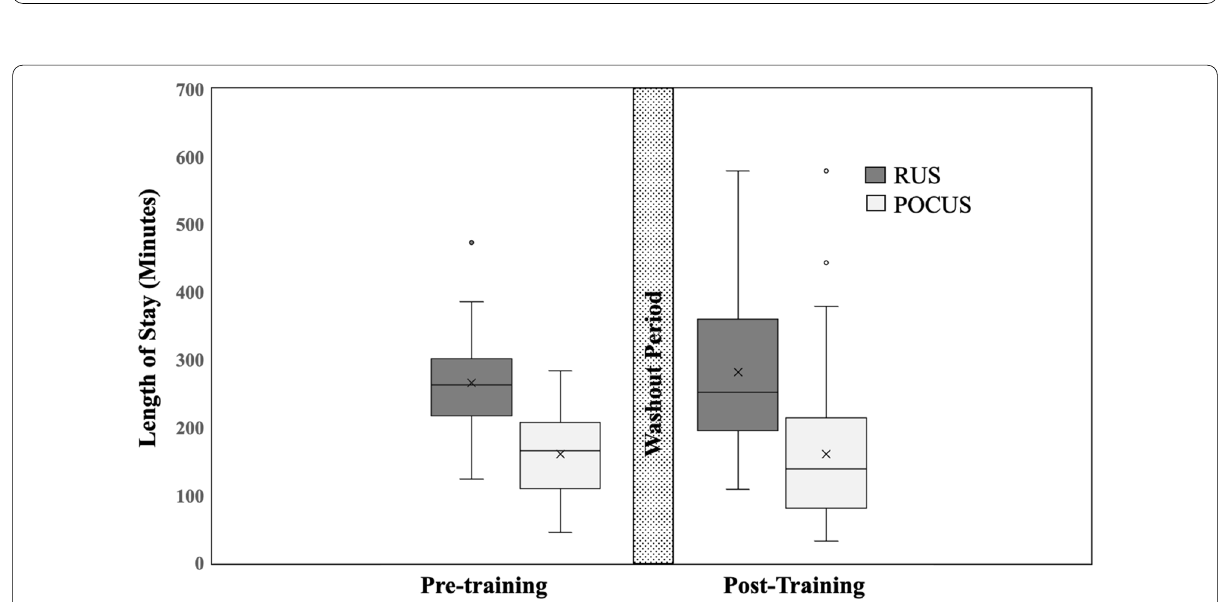
Fig. 3 Box plot of ED length of stay (LOS) in pre- and post-intervention between POCUS and radiology ultrasound (RUS) with 1-year washout period (gray bar). Circular symbol outliers; X = =